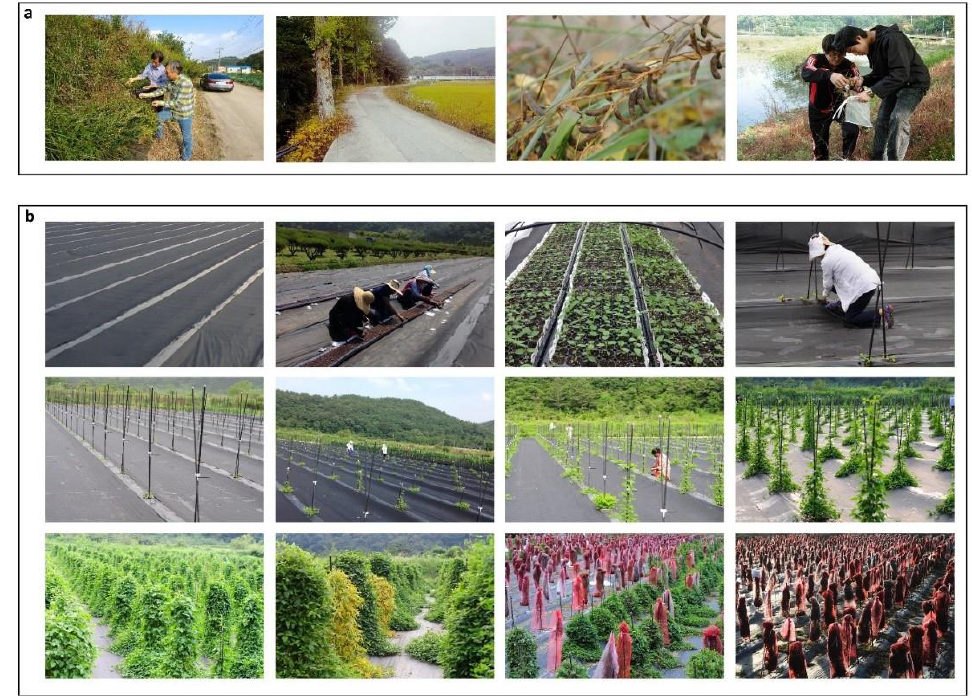
Figure 2. Wild soybean germplasm. ( a ) Wild soybean germplasm distribution and collection. ( b ) Different stages of in situ propagation and characterization at CWLGC.